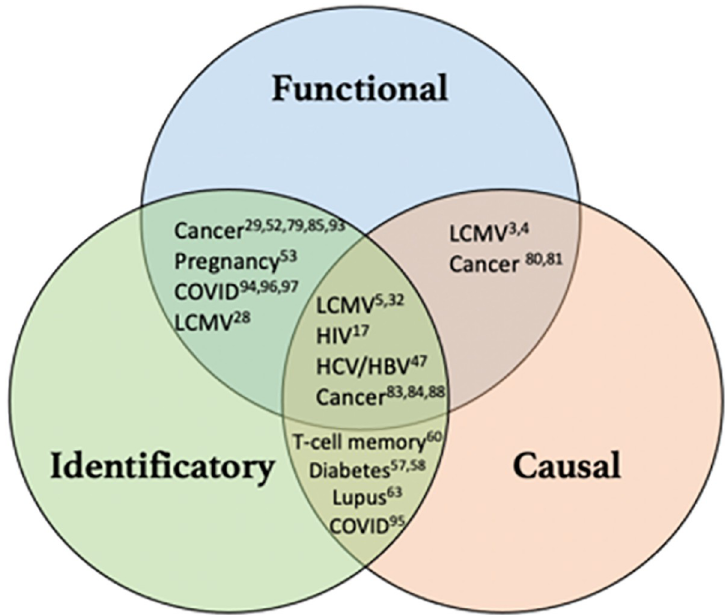
Fig 4. Examples of absence of overlap between the 3 approaches to exhaustion. COVID, Coronavirus Disease; HBV, hepatitis B virus; HCV, hepatitis C virus; LCMV, lymphocytic choriomeningitis virus.